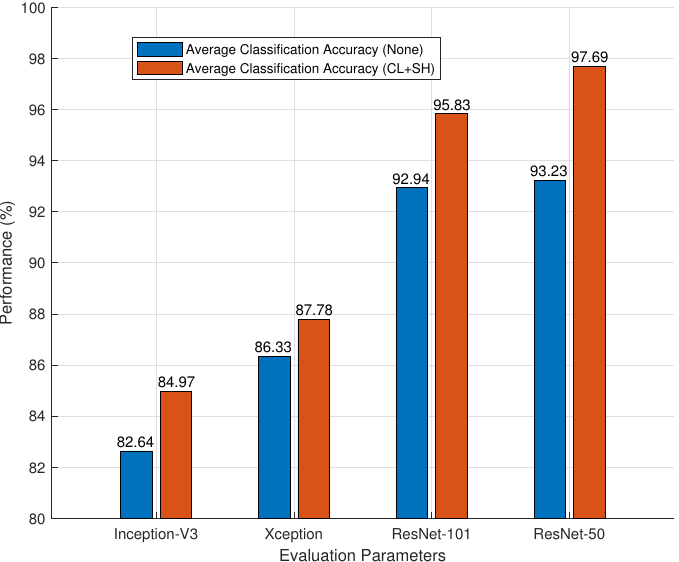
Figure 7. Performance evaluation in terms of ACA by deep learning classifiers coupled with GAN- based when CL + SH is used for preprocessing.